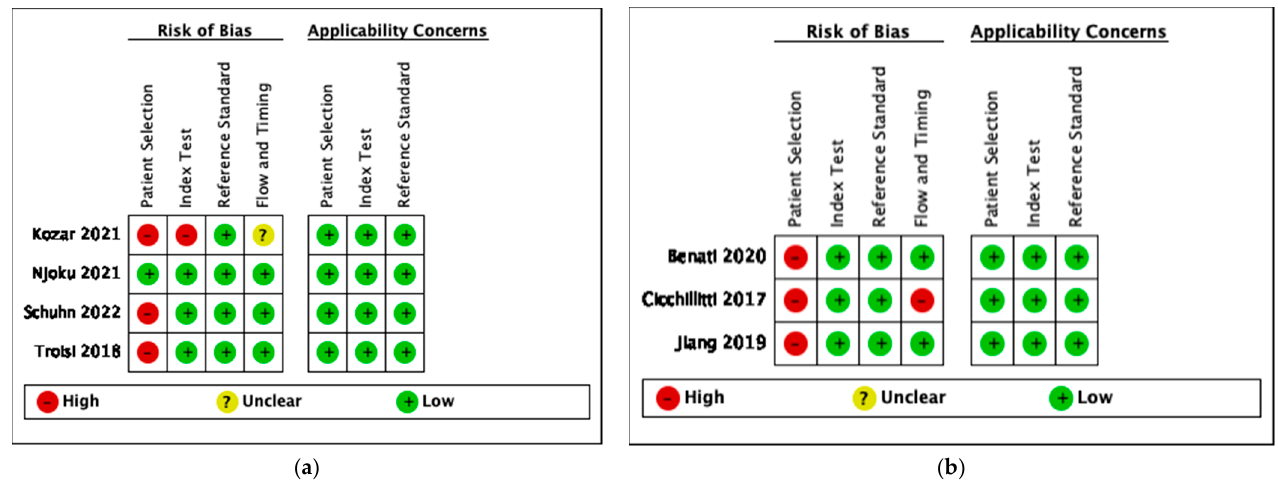
Figure 4. ( a ) Risk of bias and applicability concerns summary: review authors’ judgements about each domain for metabolomic studies ( b ) Risk of bias and applicability concerns summary: review authors’ judgements about each domain for circulating tumor material studies.